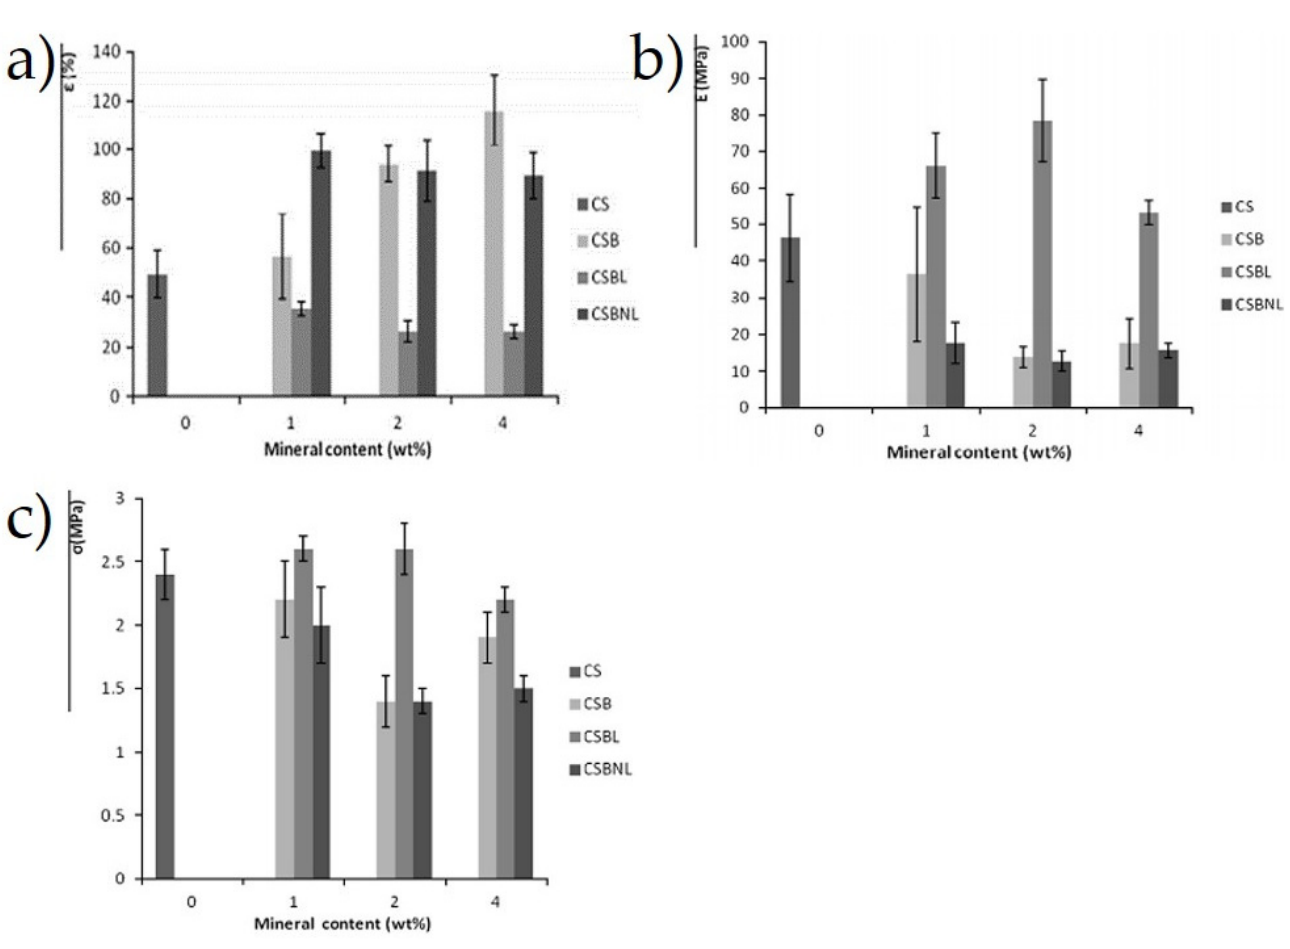
Figure 6. ( a ) Elongation at break ( ɛ ), ( b ) tensile strength ( σ ), and ( c ) Young’s modulus (E) of neat cassava starch film (at 0 wt.%) and 1, 2, and 4 wt.% of CSB-CSBL-CSBNL mineral composite films [151].